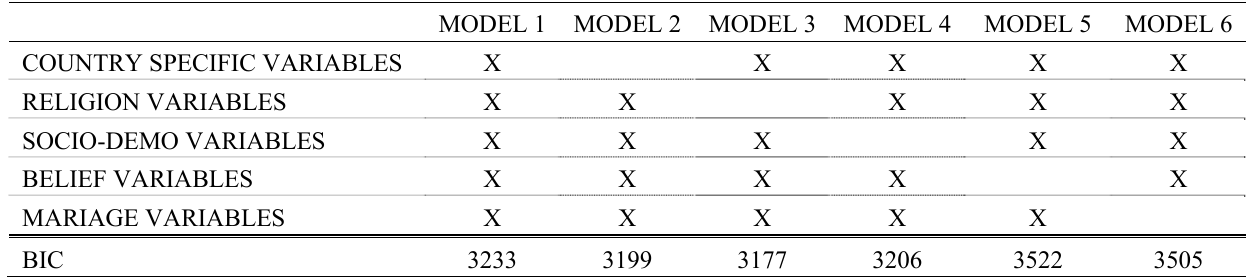
Table 4. Bayesian information criteria (BIC) for females, all countries.